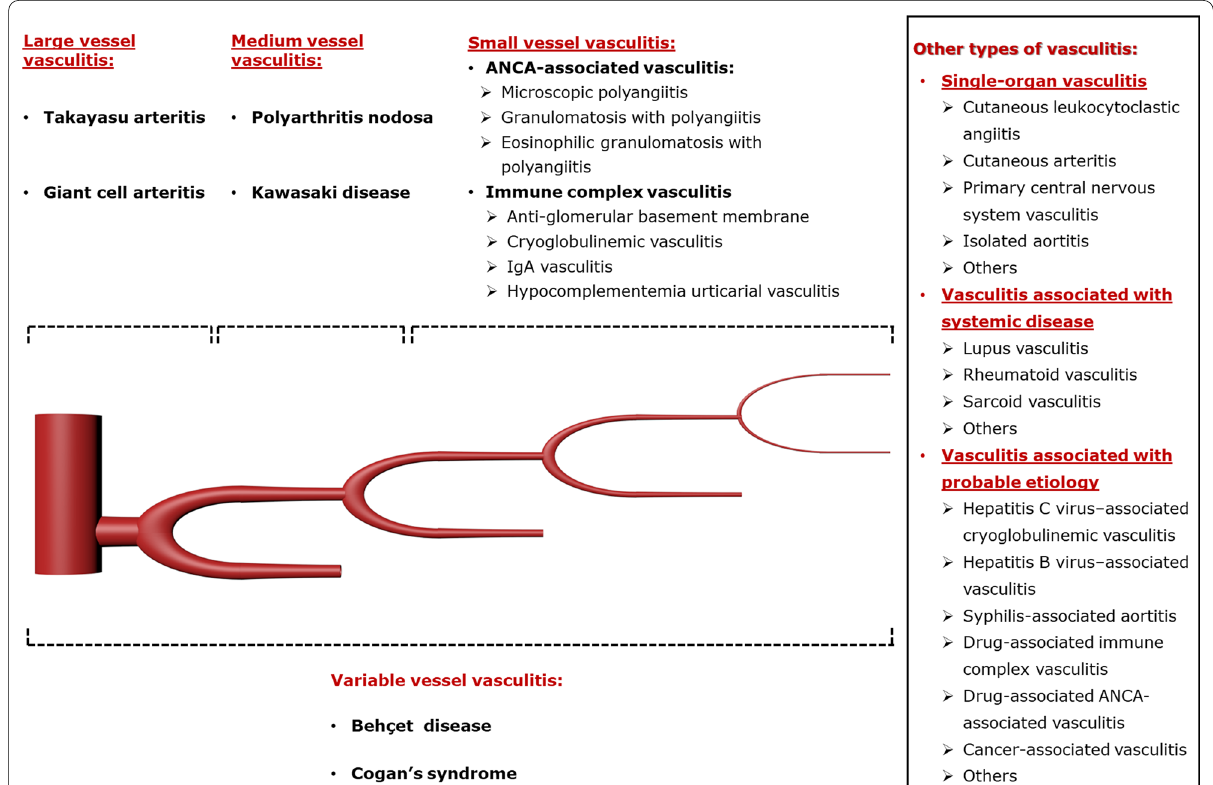
Fig. 1 Diagram of various types of vasculitis based on the size of the affected vessel and